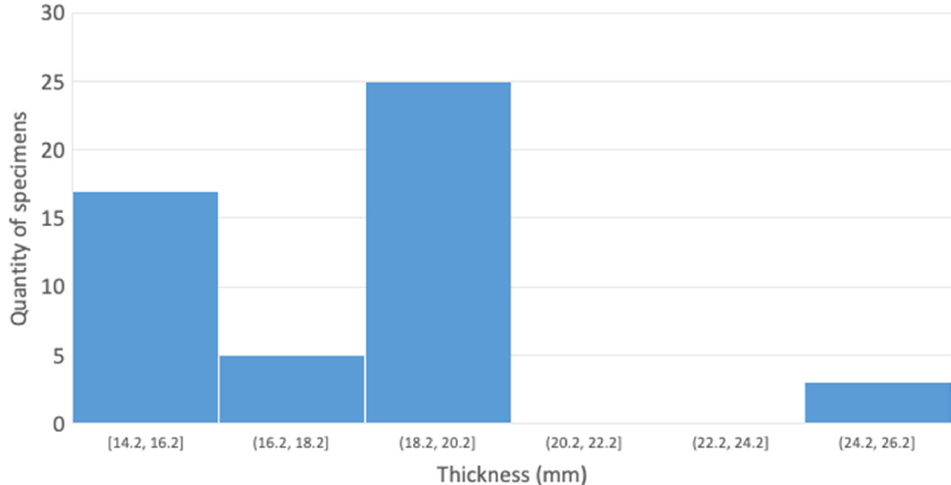
Figure 15. Histogram of thickness with CP transverse butt-welded joint samples .